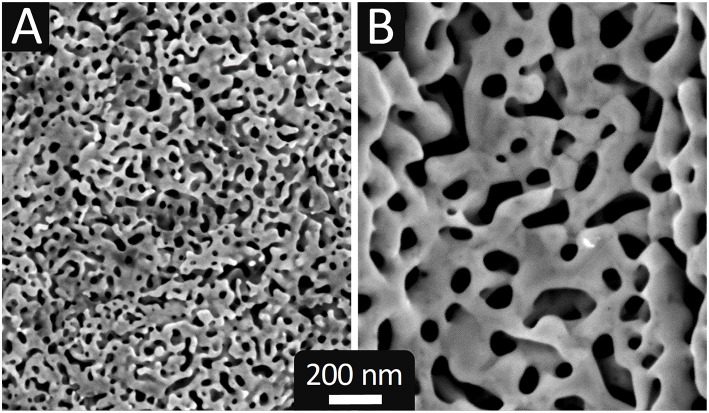
SEM images of np-Au electrodes elaborated by: (A) electrochemical dealloying at 0.7 VSME in HClO4 (0.77 mol L−1) at 60°C for 53 h; (B) chemical dealloying in HNO3 (14.2 mol L−1, 65 wt.%) at 80°C for 12 h.